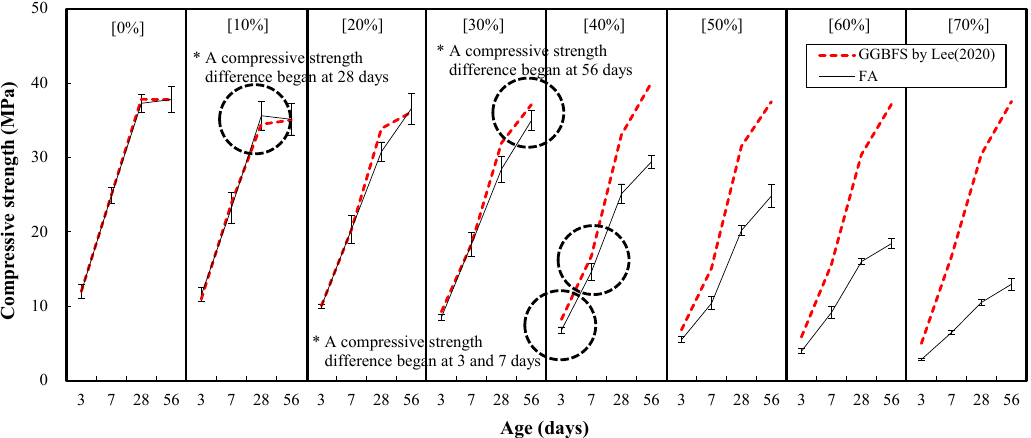
Figure 7. Results of the compressive strength of OPC and FA compared with GGBFS as measured by Lee (adapted from [26]) by age.